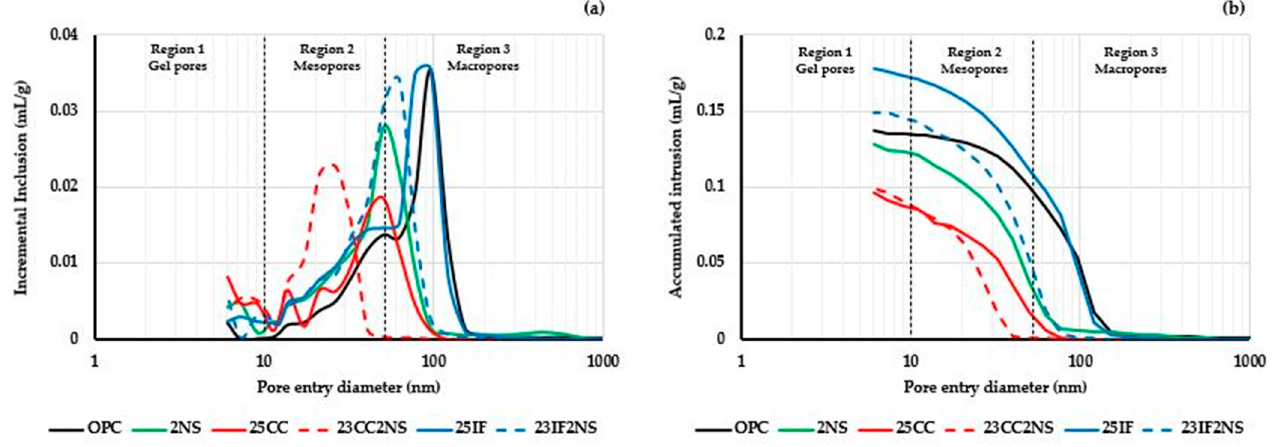
Figure 7. Pore entry diameter distribution of the pastes at 28 days of hydration: ( a ) incremental intrusion and ( b ) accumulated volume. Region 1: Gel pores (<10 nm); Region 2: Mesopores (10–50 nm); Region 3: Macropores (>50 nm).